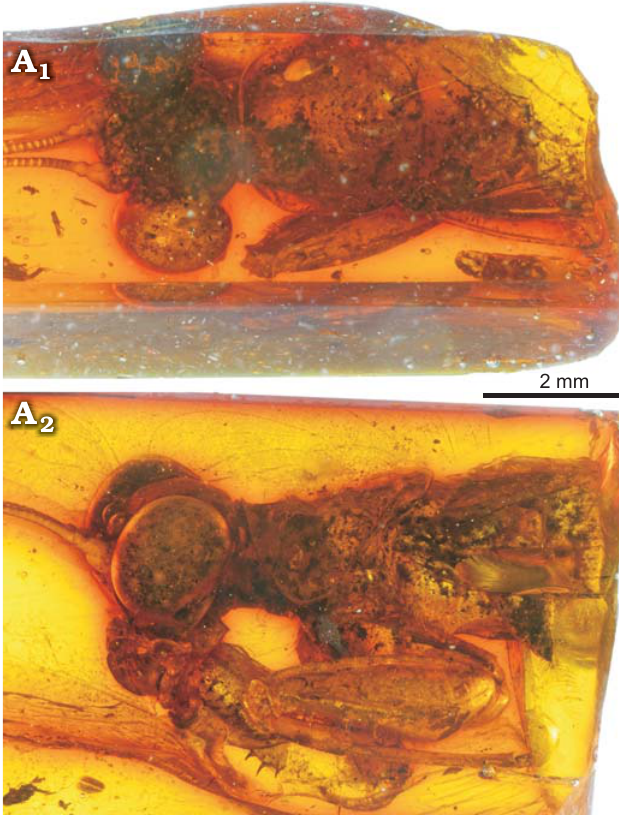
Fig. 5. Mantoidid mantis Pseudomantoida extendidera gen. et sp. nov., holotype MNHN-F.A71141, Le Quesnoy, France, Eocene. General view from above (A 1 ) and left side (A 2